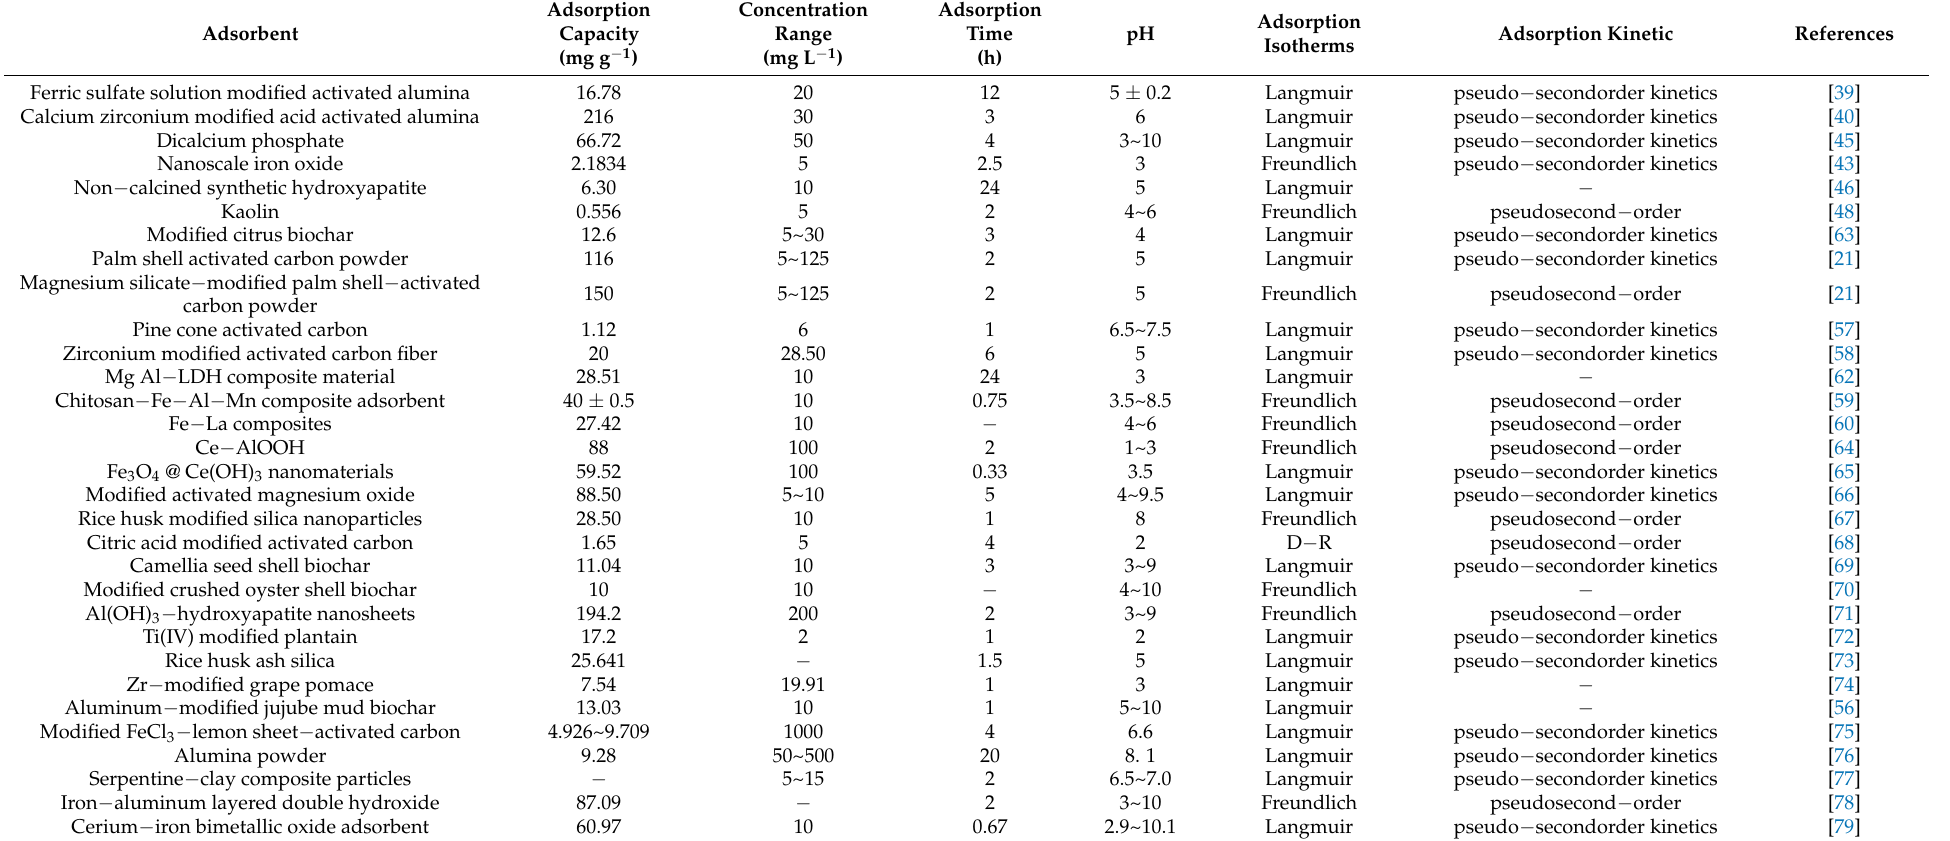
Table 1. Summary of adsorption capacity of different adsorbents for fluoride in